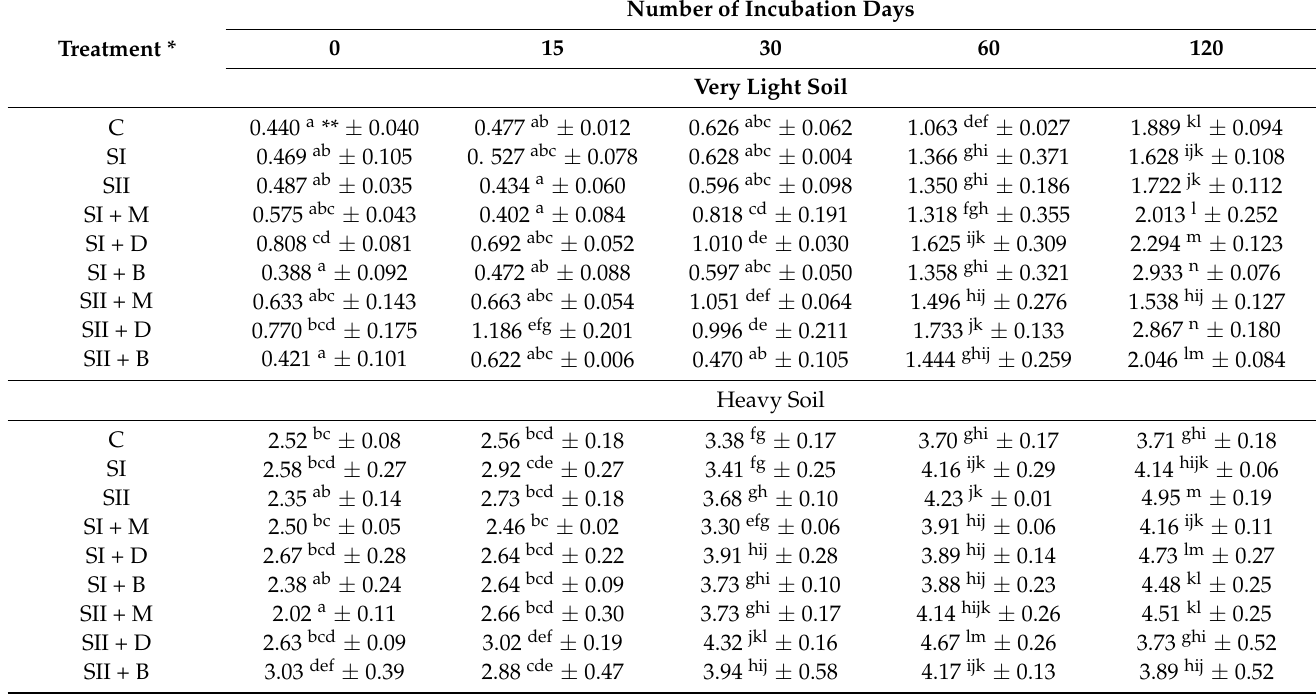
Table 4. Zinc content in very light and heavy soils throughout the incubation experiment (mg Zn kg − 1 d.m. ±